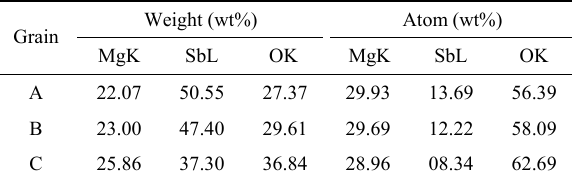
Table 2 Energy disperse spectroscopy (EDS) data of the grains A–C marked in Fig. 4(c)